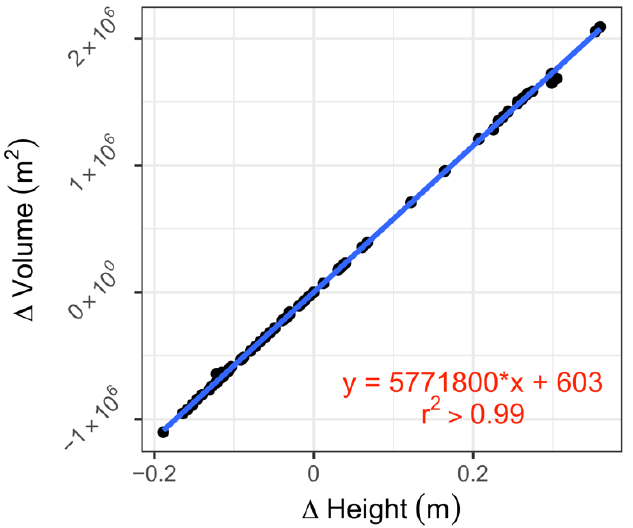
Figure 6. Example of the linear relationship determined between change in height and calculated change in volume to create a rating curve at Bay Tree Lake.